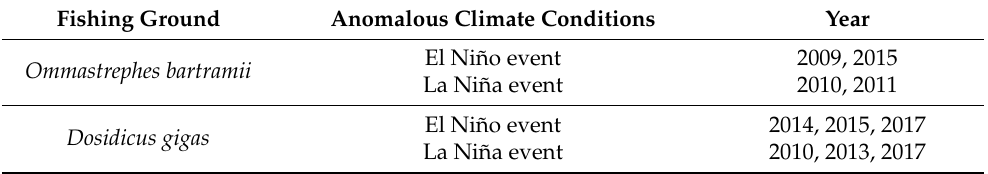
Table 3. The classification of the El Niño and La Niña event from 2008 to 2018 according to the time of sample collection and the definition of El Niño and La Niña. All other unclassified years were